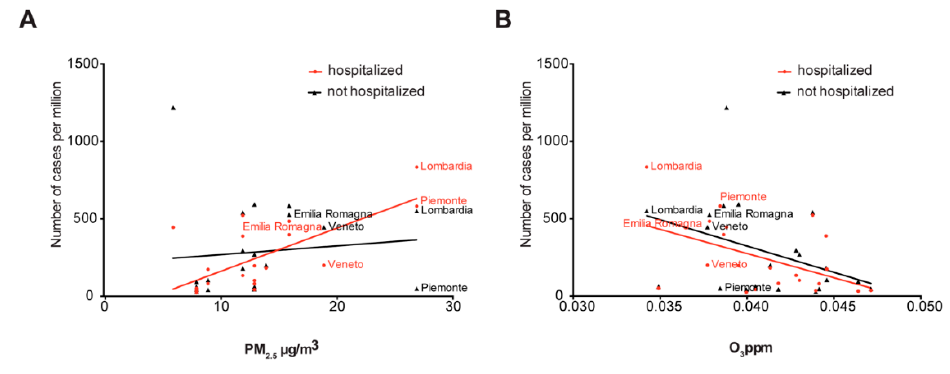
Figure 4. Correlation between hospitalized and not hospitalized cases in 21 Italian regions using PM 2.5 and O 3 . ( A ) Scatter plot of the hospitalized (red points) and not hospitalized (black points) versus the concentration of PM 2.5 in 21 Italian regions. Red line, positive correlation ( R 2 = 0.4891, p = 0.0004); black line, no significant correlation ( R 2 = 0.01154, p = 0.6430). The labels represent the four regions with the highest number of cases per million. ( B ) Scatter plot of the hospitalized (red points) and not hospitalized (black points) versus the concentration of ozone in 21 Italian regions. Red line, negative correlation ( R 2 = 0.2355, p = 0.0257); black line negative correlation ( R 2 = 0.1590, p = 0.0734). The labels represent the four regions with the highest number of cases per